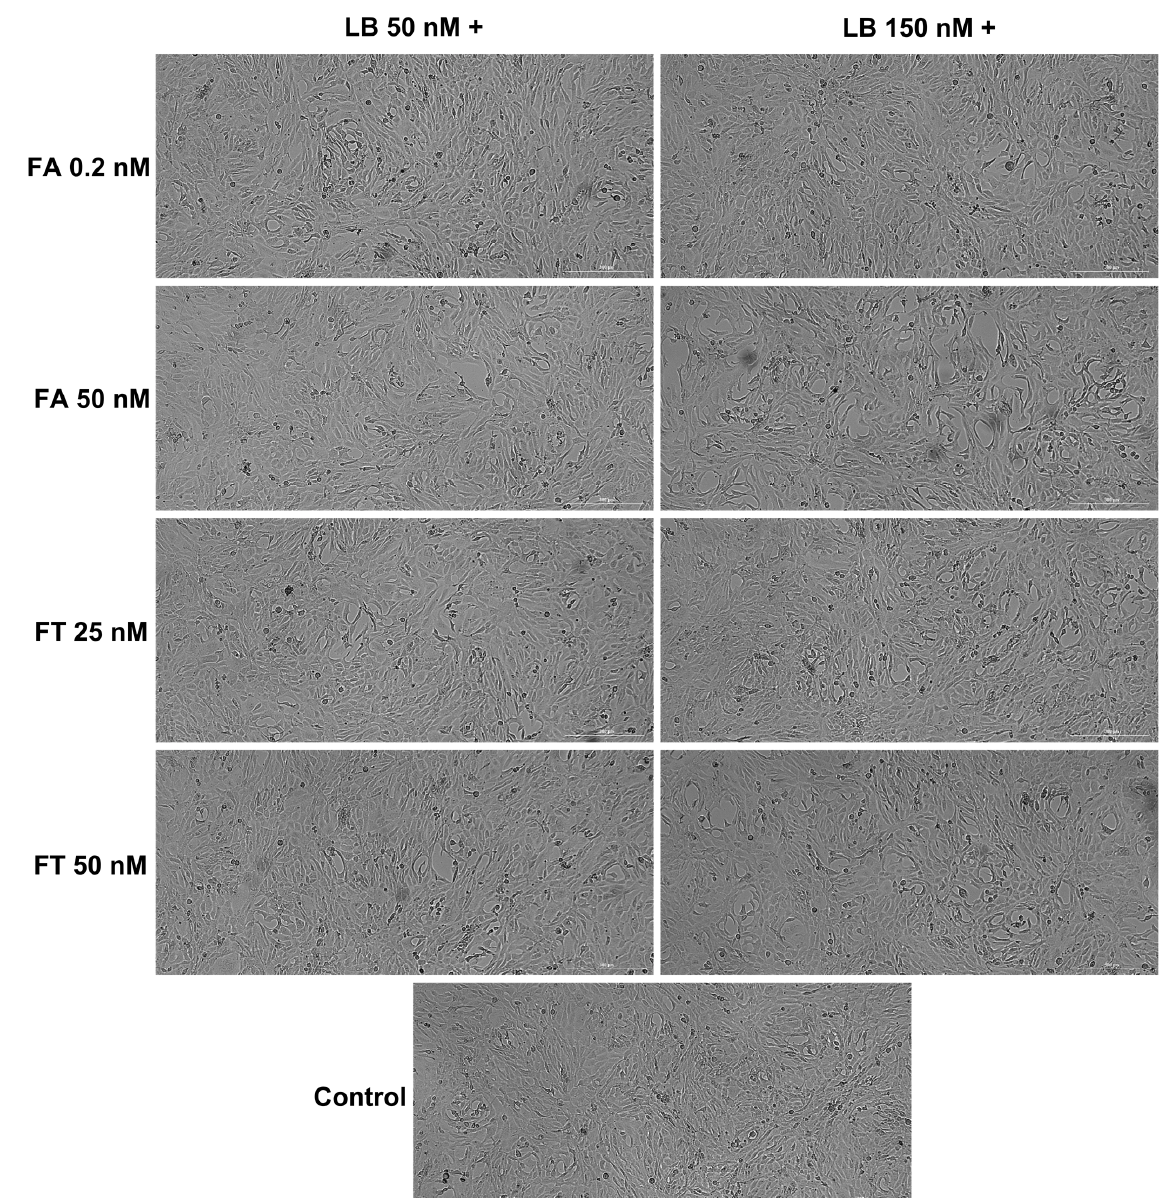
Figure 4. Morphological analysis of HepaRG hepatocytes following the 72-h combined treatment of LB 50 and 150 nM with FA (0.2 and 50 nM) and FT (25 and 50